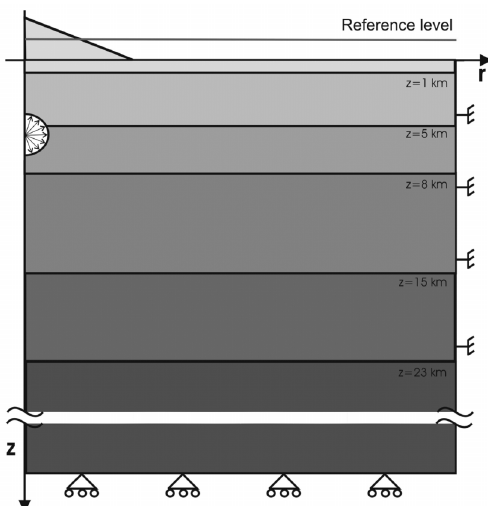
Fig. 4. Model geometry used to estimate the influ- ence of topography on surface deformation and grav- ity field. The features in the picture are not in